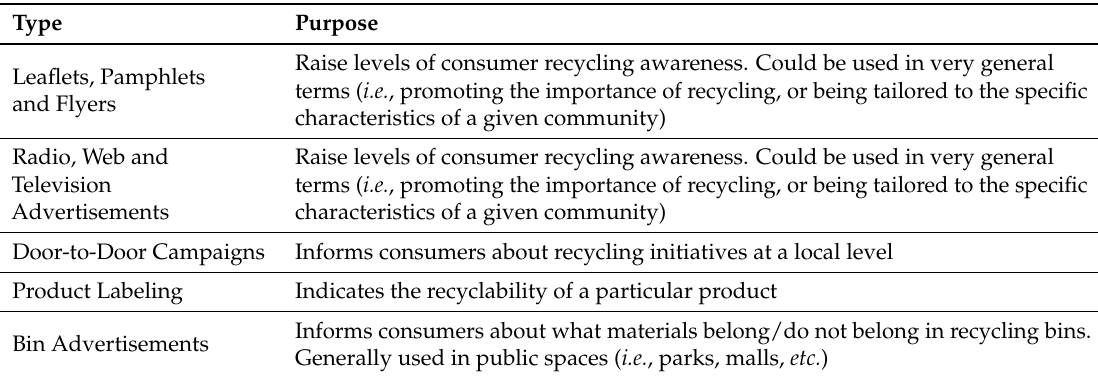
Table 1. Types of Promotion and Education (P&E)